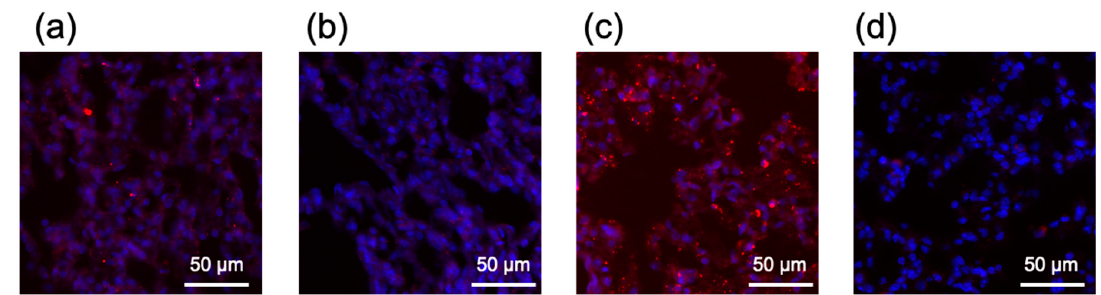
Figure 9. Distribution of Lipofectamine LTX-based LNPs in the lung. Using GLuc mRNA labeled with Cy5, two LNP formulations were prepared by mixing the mRNA with minimal or maximal volume of lipofectamine LTX solution that the manufacture suggests to use (( a , b ) Lipo-Min and ( c , d ) Lipo-Max). Then, the LNPs were intravenously injected to the mice. Five min after the injection, the lung was excised for preparation of frozen tissue sections. Blue: nucleus (DAPI). ( a ) Lipo-Min loaded with non-PEGylated mRNA. ( b ) Lipo-Min loaded with 20 PEG-OligoRNAs/mRNA. ( c ) Lipo-Max loaded with non-PEGylated mRNA. ( d ) Lipo-Max loaded with 20 PEG-OligoRNAs/mRNA.